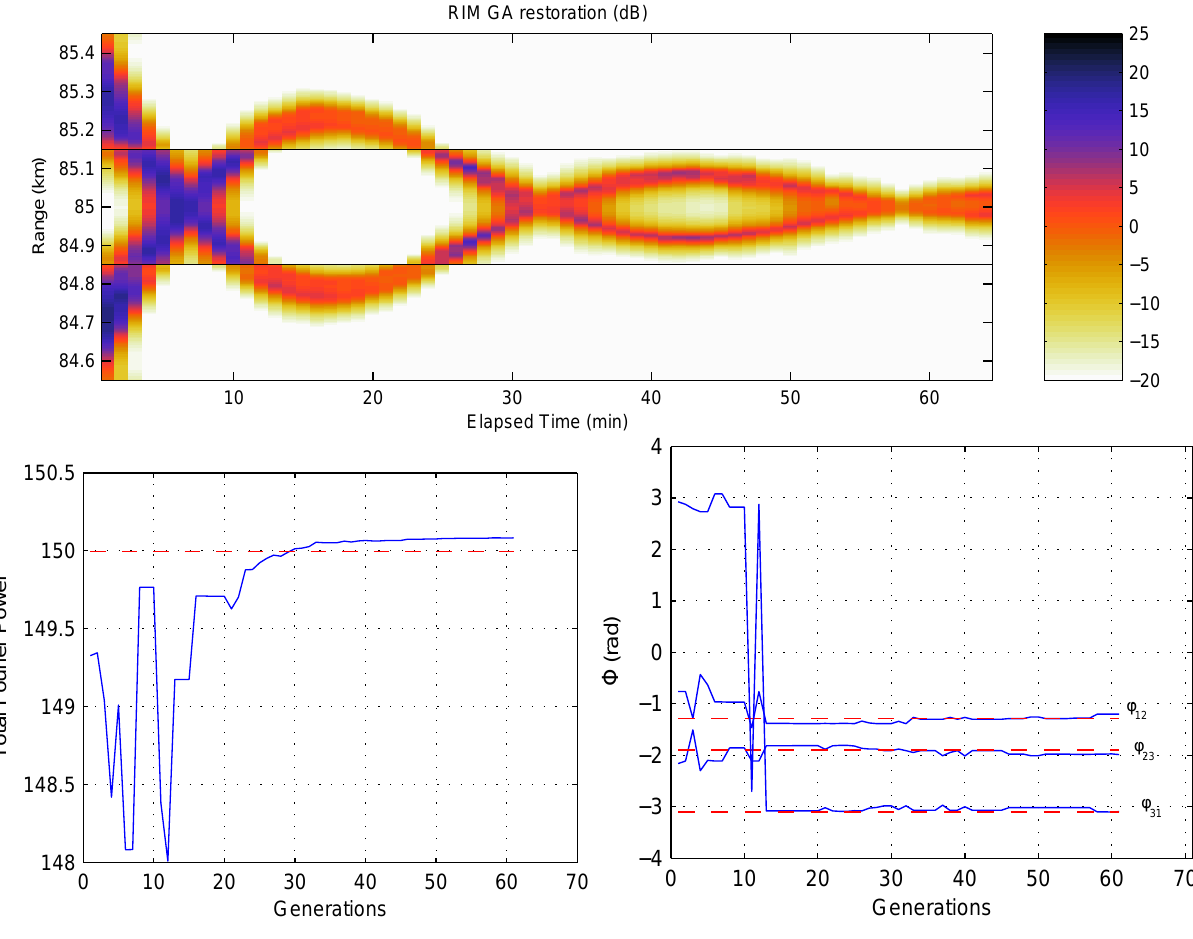
Fig. 6. Capon restored RIM image using the GA-based phase calibration method (top panel). The convergence is observed in both the total Fourier power (fitness) and the estimated phase values shown in the bottom